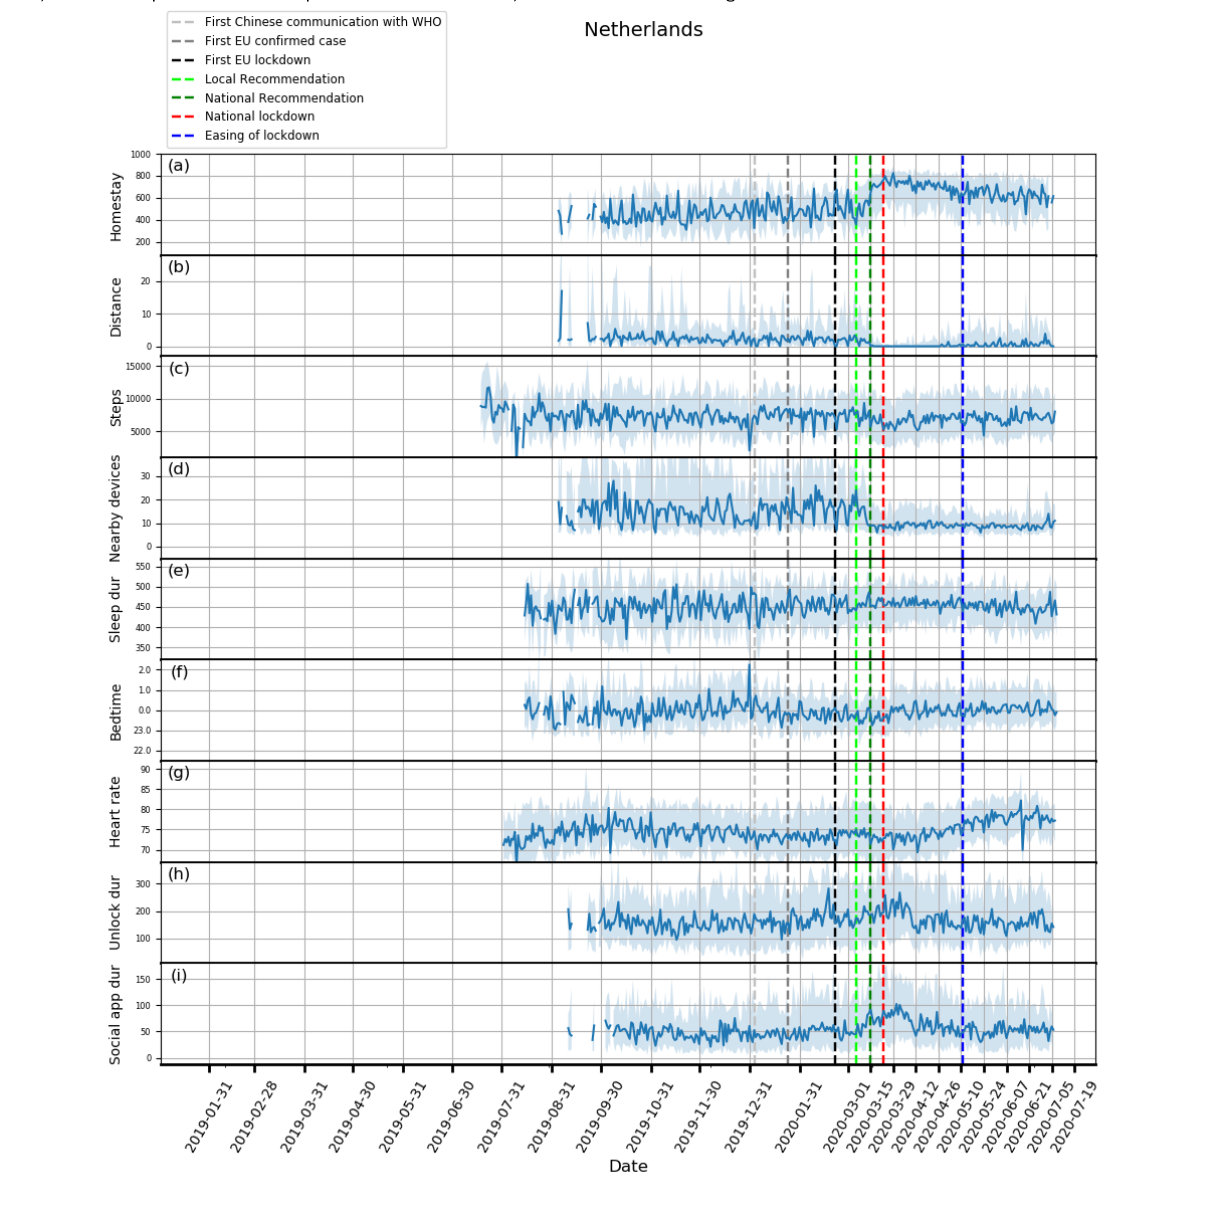
Figure 5. Behavioral changes for the Netherlands (103 participants). (a) homestay duration, (b) maximum distance from home, (c) Fitbit step count, (d) maximum number of nearby devices, (e) total sleep duration, (f) bedtime, (g) heart rate, (h) unlock duration, (i) social app duration. Solid line: median; shade: 25th percentile to 75th percentile. dur: duration; WHO: World Health